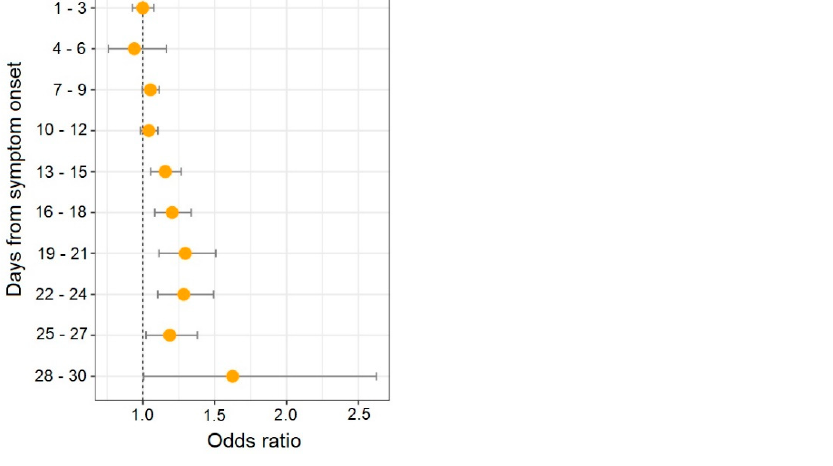
Figure 3. Association between serial changes of NLR and mortality in COVID-19 patients (adjusted odds ratio and 95% confidence interval).